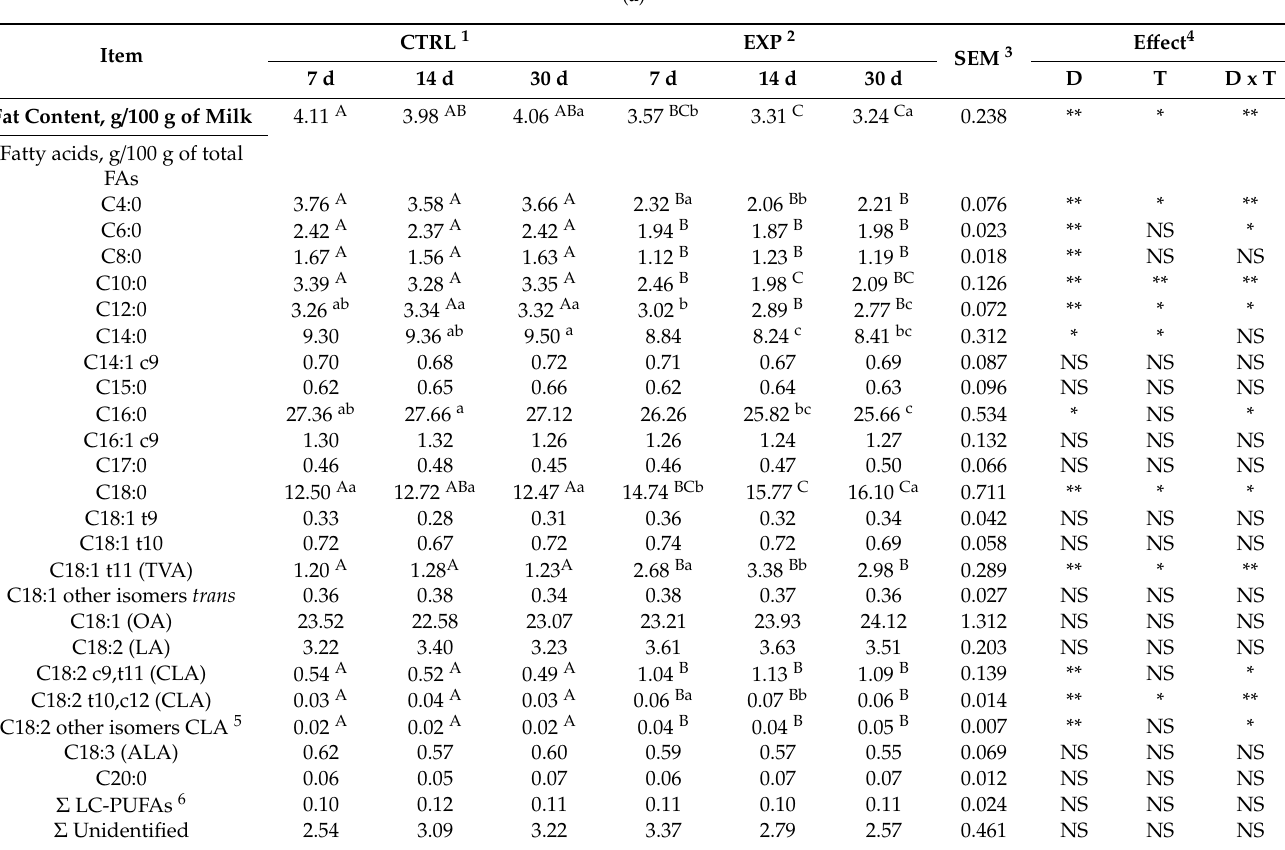
Table 4. ( a ) Means of fat and fatty acid content of total lipids of milk from cows that were fed the two diets (CTRL and EXP) at the three sampling times (7, 14, and 30 d). ( b ) Means of fatty acid (FA) groups with varying degrees of saturation and carbon chain length, desaturase index, and atherogenic index of milk from cows that were fed the two diets (CTRL and EXP) at the three sampling times (7, 14, and 30